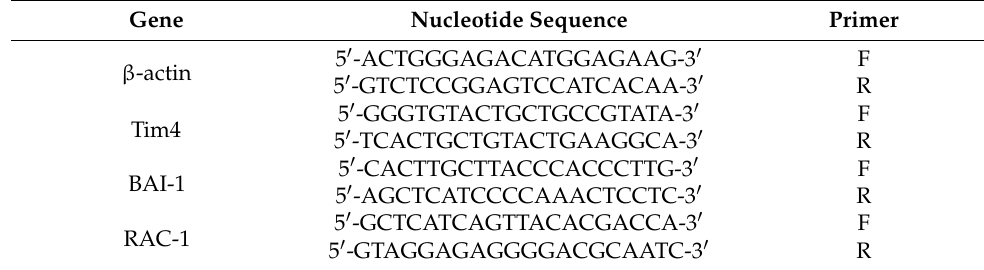
Table 1. Nucleotide sequence of the specific primers used for PCR